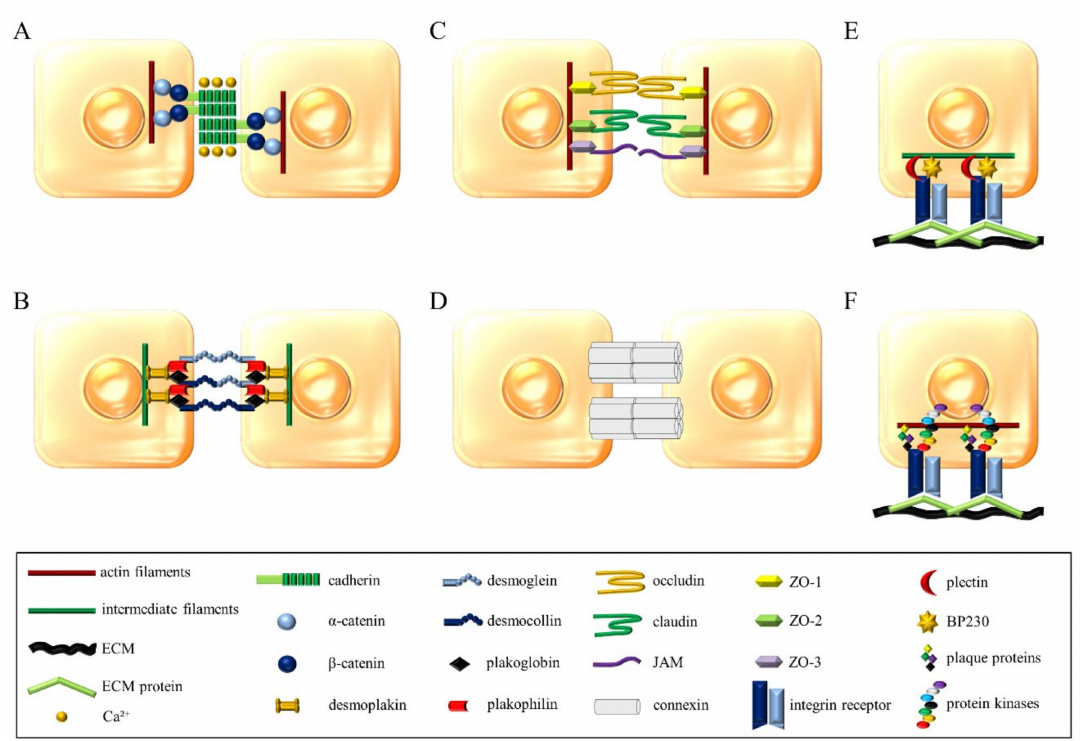
Figure 2. Principal interactions of cell-cell junctions: ( A ) Adherens junctions, ( B ) desmosomes, ( C ) tight junctions, ( D ) gap junctions; and cell-ECM junctions: ( E ) Hemidesmosomes, ( F ) focal